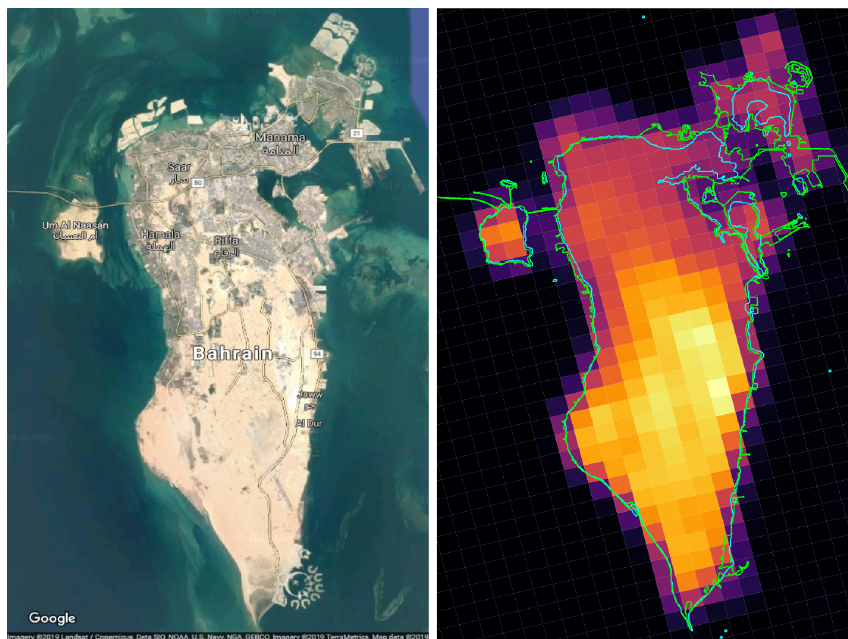
Figure 5. The left plot shows a Google Maps satellite view of the island country of Bahrain. The smaller island Um Al Naasan to the west has a size of approximately 4km × 5 . 5km. The colour mesh plot on the right-hand side is made using TROPOMI geolocation zoom radiance data of band 6 for orbit 1305. The scene is situated at nadir and has a ground pixel size of approximately 1 . 8km × 1 . 8km. The two reference coastline datasets described in the text are plotted in light blue (500m accuracy WVS) and light green (50m accuracy PGSD). The contrast between water and the desert-type land is large. In the north and south-east newly created artificial islands can be seen which are measured by TROPOMI and are visible on Google Maps but are not included in the coastline references, as these were produced using older satellite